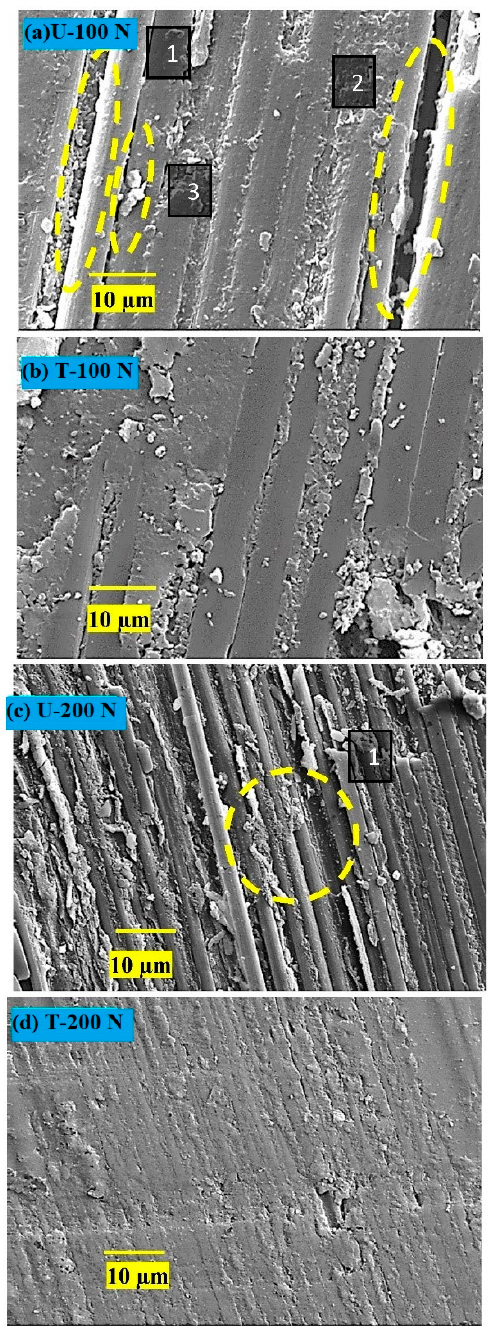
Figure 12. Worn surfaces of composite pins slid at 100 N and 200 N; ( a ) and ( c ) for composite U; ( b ) and ( d ) for composite T. (1) Peeled-off fiber during shearing stresses due to weak fiber-matrix interface. Such fibers are vulnerable and removed easily from the surface, leading to cavities and increased fiber-matrix debonding (2). Fiber surfaces are cylindrical, indicating less participation in the wear-thinning process. (3) Pulverization of carbon fibers leads to more wear.